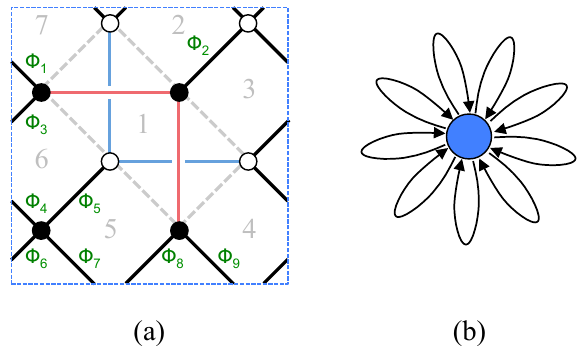
Figure 11. a) Backreaction of an instanton on face 1 of the dimer for phase 1 of PdP 4 and b) quiver for the resulting BFT.